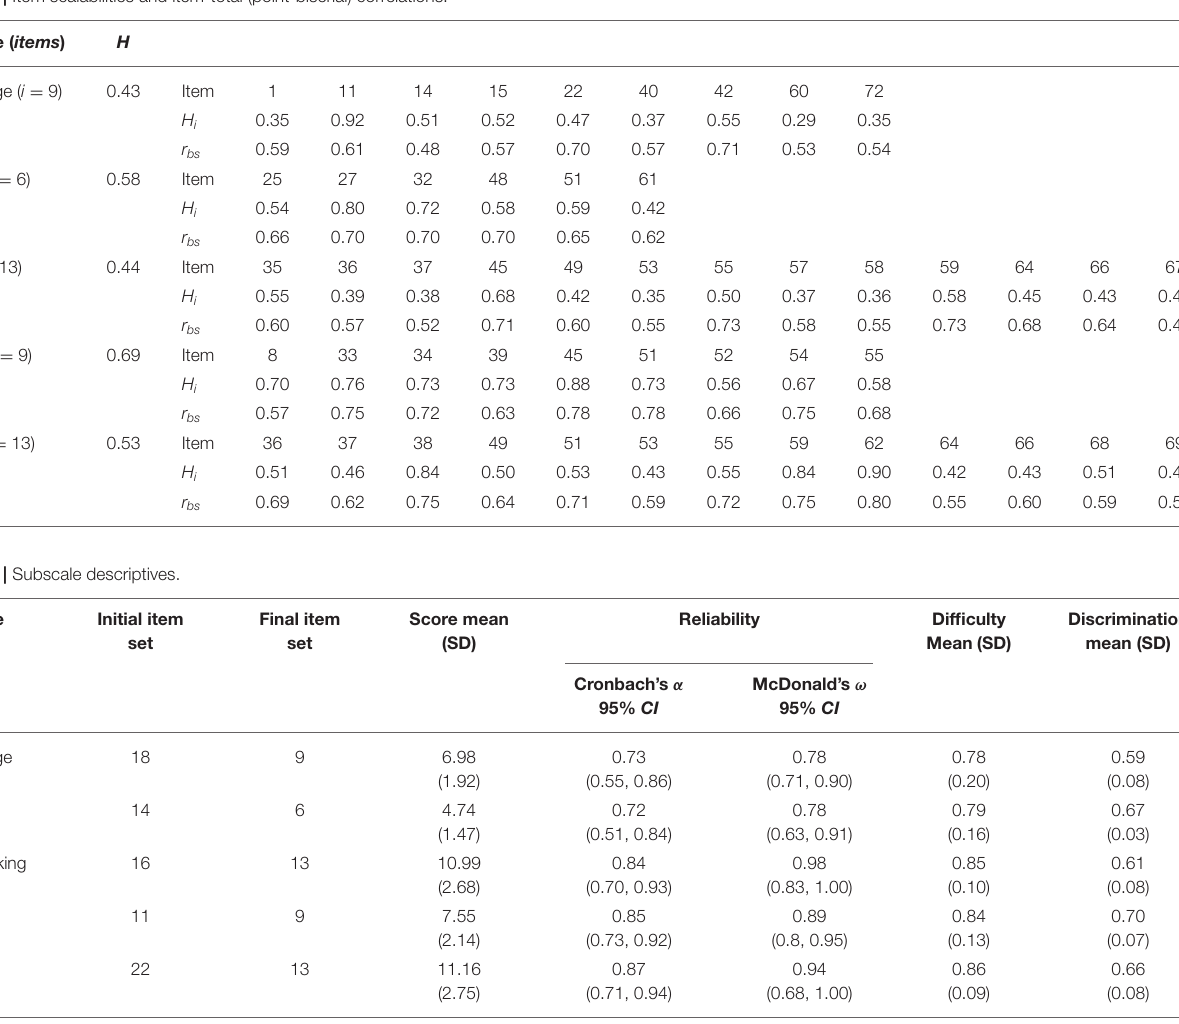
TABLE 2 | Item scalabilities and item-total (point-biserial) correlations.